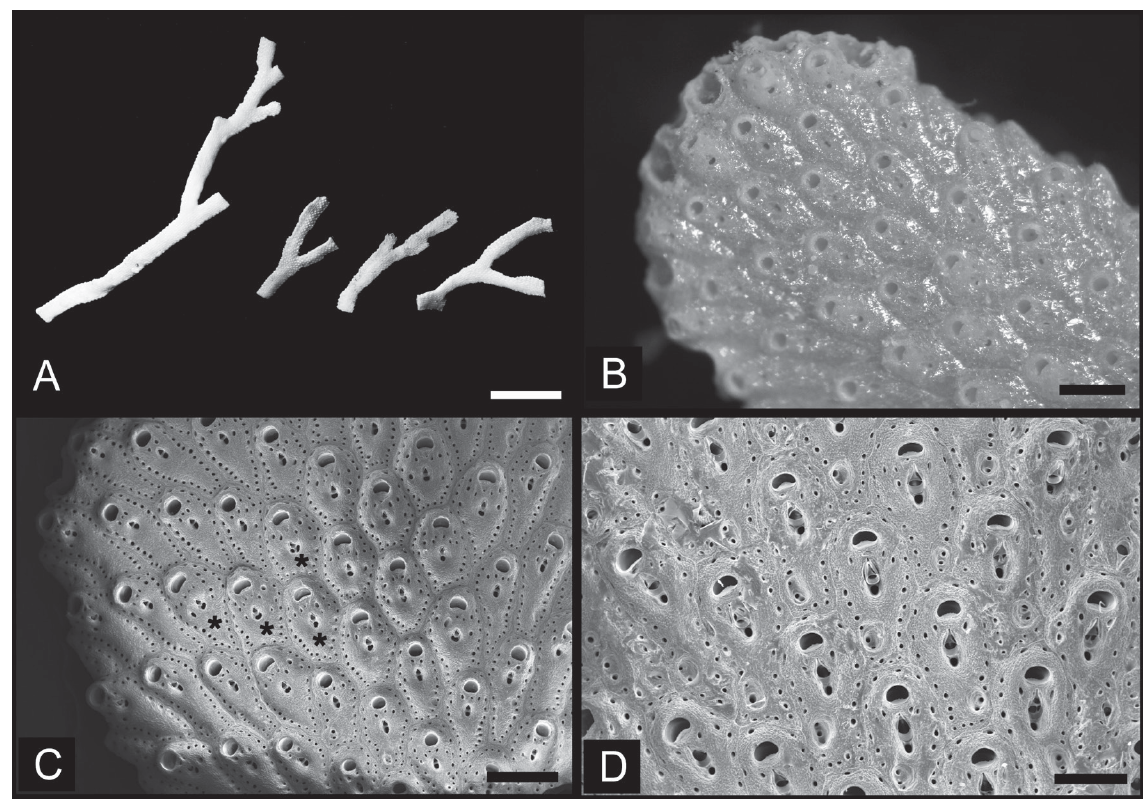
Fig. 14. Adeonellopsis parvirostrum sp. nov. A . Colony branches from oshima shin-sone, N of Amami oshima (NsMT-Te780). B . Distal end of branch (NsMT-Tes26). C . Young autozooids and some gonozooids (four of them are indicated with asterisks) at distal end of branch (NsMT-Tes26). D . Gonozooids with broad, curved orifice, small triangular avicularia, and small spiramen (NSMT- TeS26). A–B = photomicrographs; C–D = SEM images. Scale bars: A = 1 cm; B–D = 500